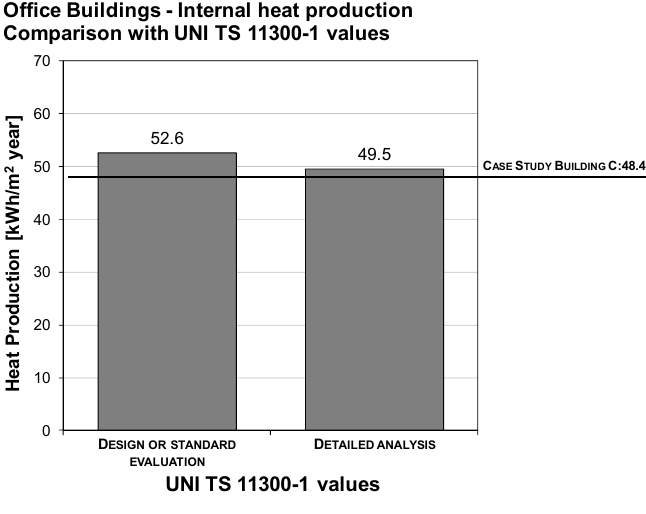
Figure 8. Comparison of the yearly internal heat production for Building C calculated by TRNSYS and the chosen scenario and the data from UNI TS 11300-1 [32], in kW h/m 2 .